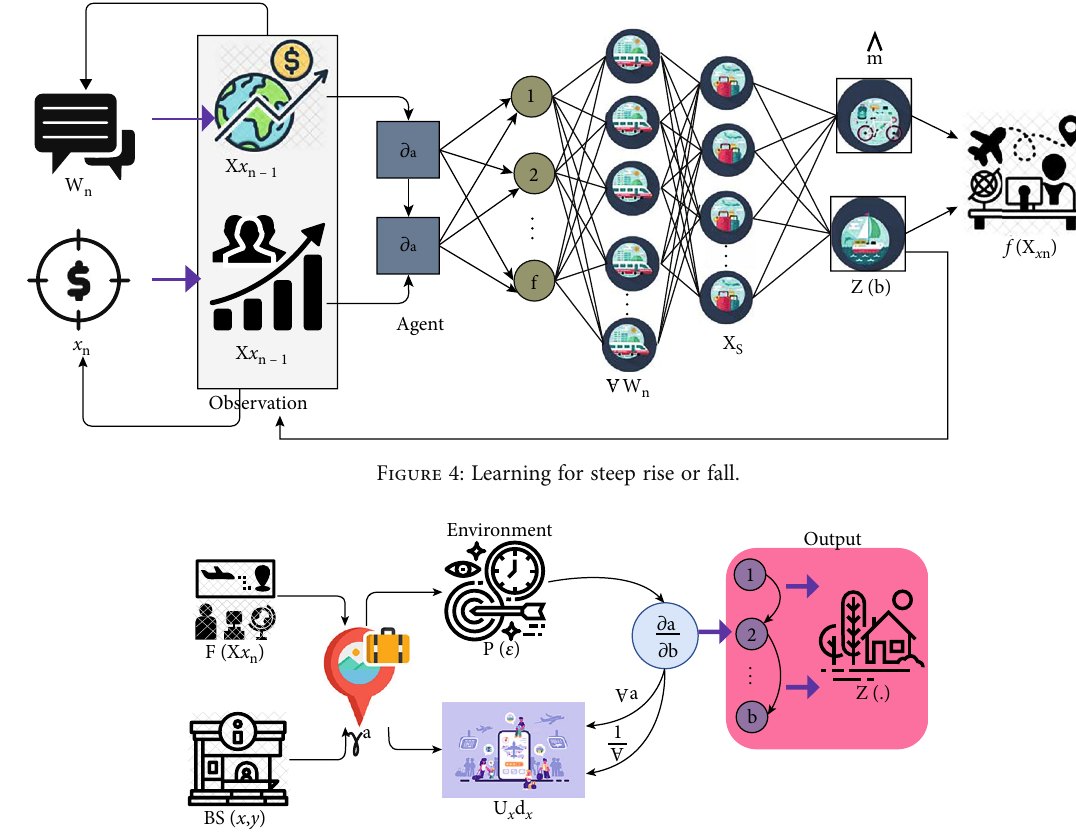
Figure 5: Target achievement using relevance